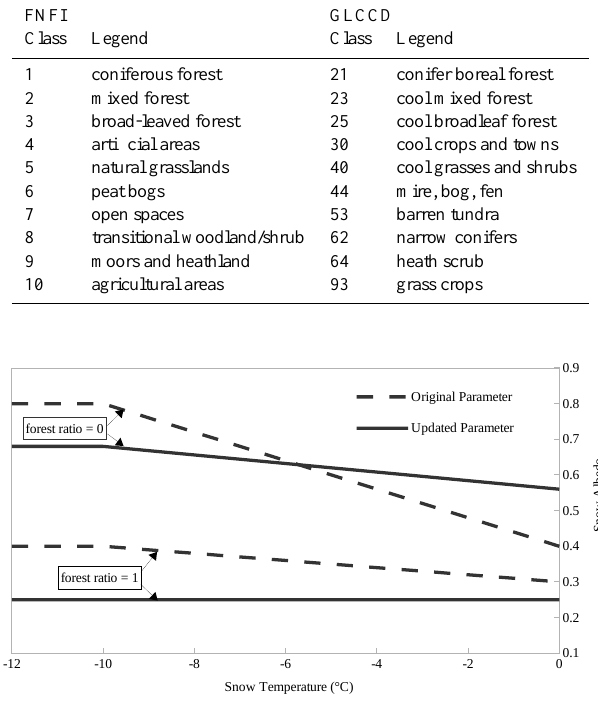
Figure B1. Modified snow albedo values in the snow albedo scheme (modified based on Fig. 3.6 in Kotlarski,